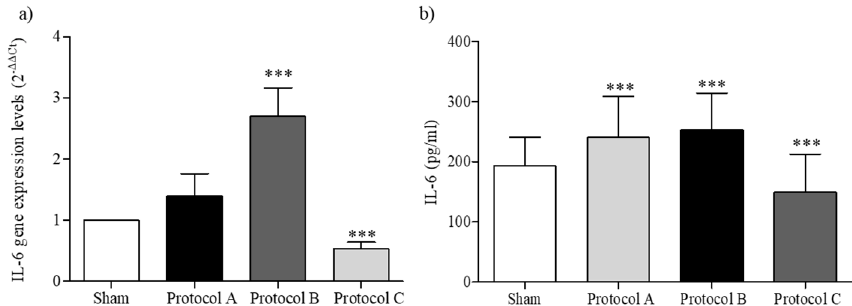
Figure 5. IL-6 expression and production. ( a ) IL-6 gene expression in HaCaT cells after different RF-EMF-exposure conditions. The mean values of gene expression levels (2 − ∆∆ Ct ) and 95% CI of three independent experiments, were reported. *** p < 0.001 with respect to sham-exposed cells. ( b ) IL-6 levels in HaCaT cell culture supernatant. The mean values ± SD were reported in triplicate experiments. *** p < 0.001 vs. sham-exposure condition.